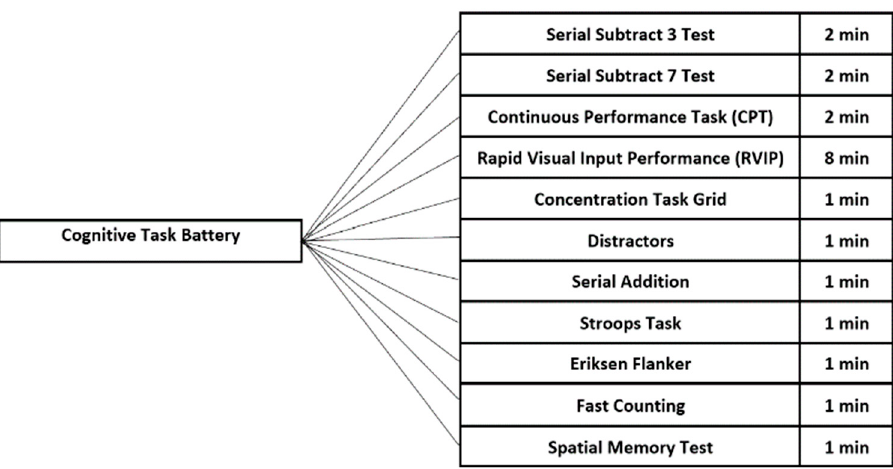
Figure 1. Order of Tasks During Cognitive Task Performance.